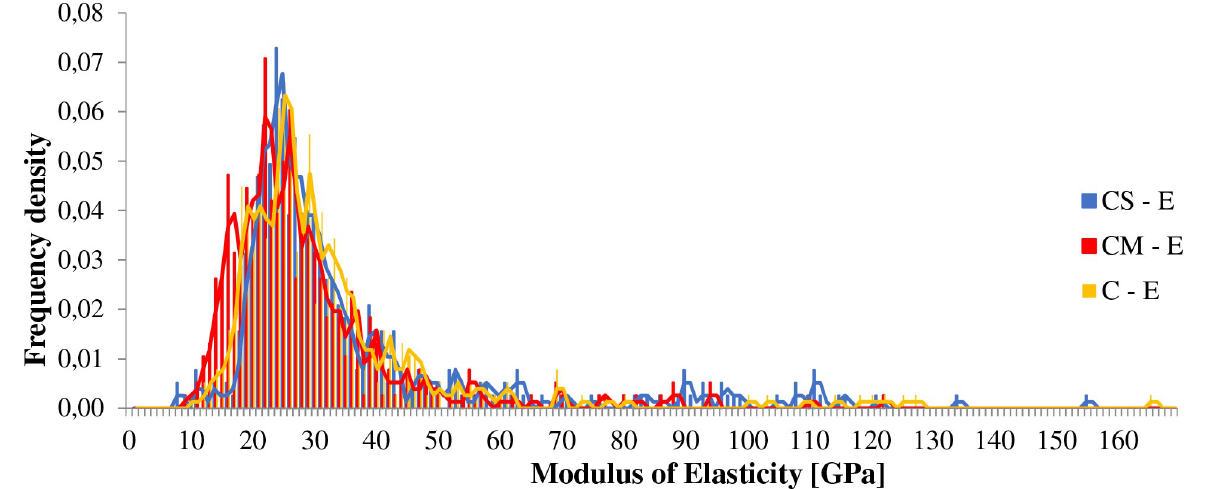
Figure 8. Histogram of modulus of elasticity with trend line for cement pastes CS, CM and C.